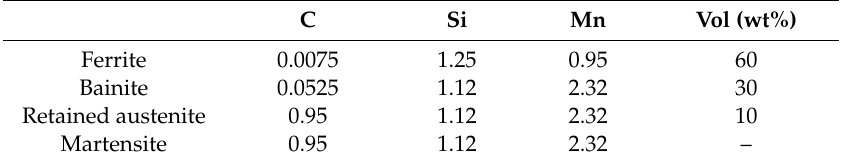
Table 3. Composition and volume fraction of Transformation Induced Plasticity (TRIP) steel (wt%).